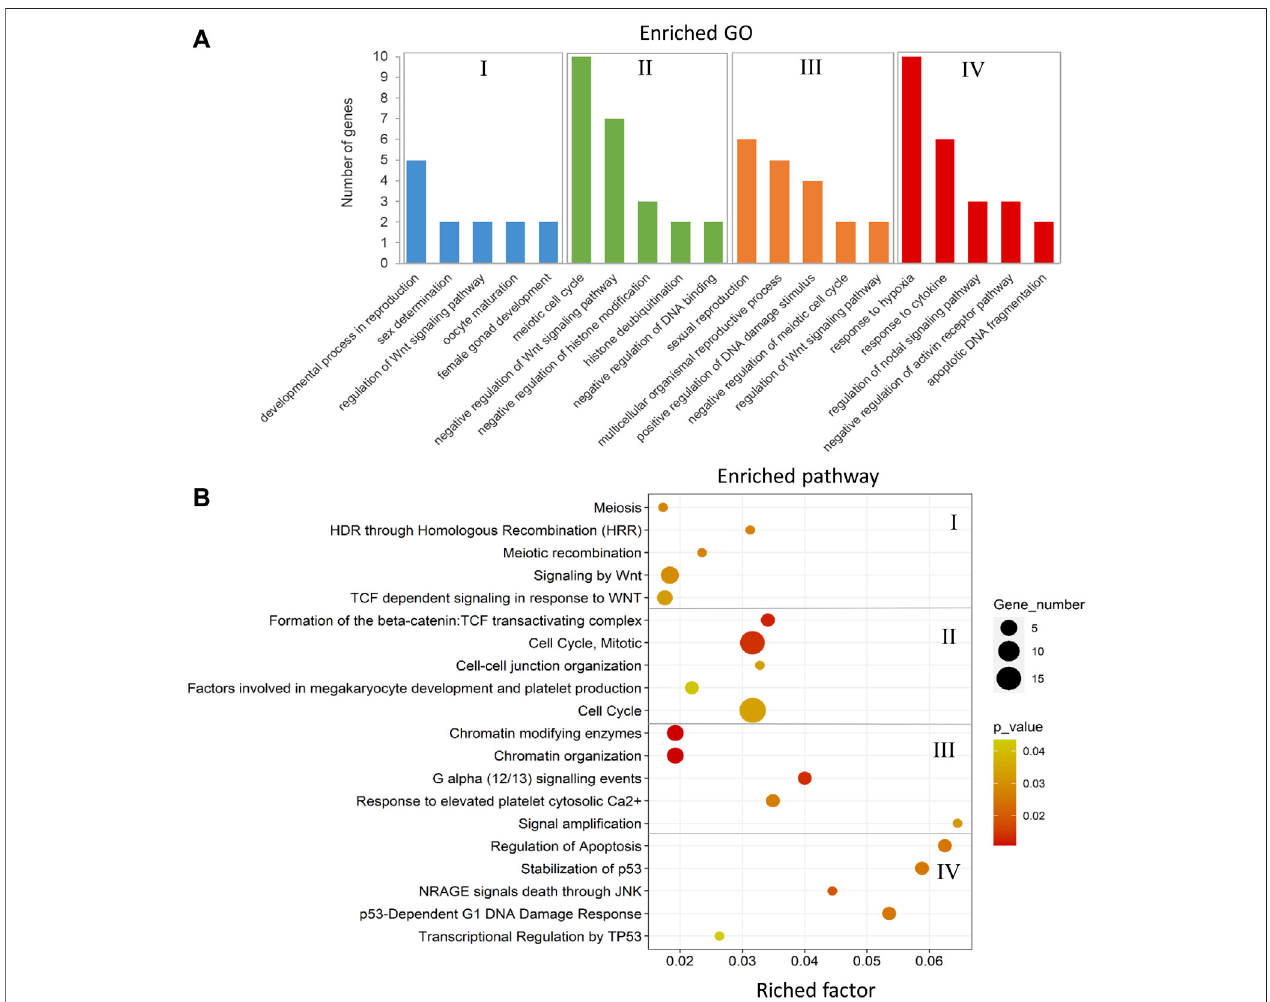
FIGURE 11 | Enriched GOs and pathways in male-biased versus female-biased family. The results of biological functional annotation analysis of genes associated with DMCs in male-biased versus female-biased family in different experimental groups: (I) female control male-biased versus female control female-biased (FCMB vs. FCFB); (II) male control male-biased versus male control female-biased (MCMB vs. MCFB); (III) female treatment male-biased versus female treatment female-biased (FTMB vs. FTFB); (IV) male treatment male-biased versus male treatment female-biased (MTMB vs. MTFB). (A) Bar charts represent the signi fi cant enriched GOs ( p < 0.05). The vertical axis represents the most important enriched GOs and the horizontal axis represents the number of signi fi cantly differentially methylated genes in each GO term. (B) Scatter plots illustrate the signi fi cant enriched pathways ( p < 0.05). The vertical axis represents the enriched pathway categories and the horizontal axisrepresentstherichfactoroftheenriched pathways. Richfactoristheratioofdifferentiallymethylatedgenenumberenriched inthepathway tothetotalgenenumber in a certain pathway. The size and colour of dots represent the gene number and the range of p -values, respectively.